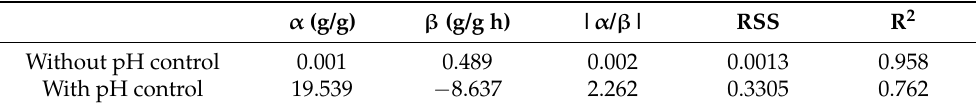
Table 4. The kinetic constants of the Luedeking–Piret model ( α : growth-linked constant; β : non- growth-linked constant), RSS, and the correlation coefficient R 2 , calculated for fermentations with and without pH control.